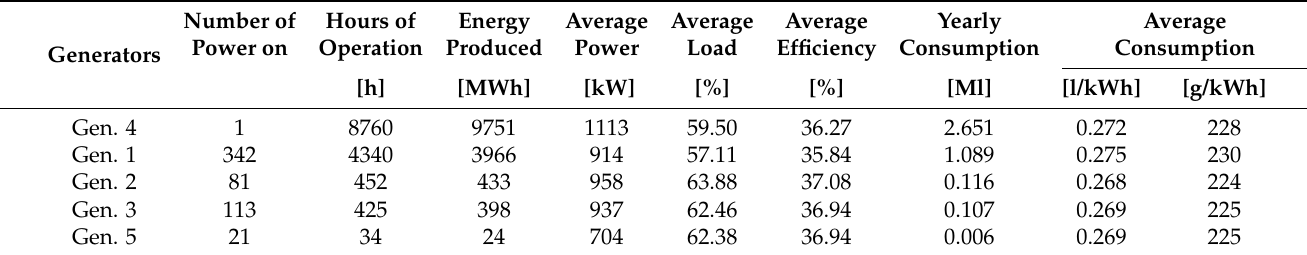
Table 20. Forecast of the annual operating data of the generators to 2030 in a purely conventional production scenario.